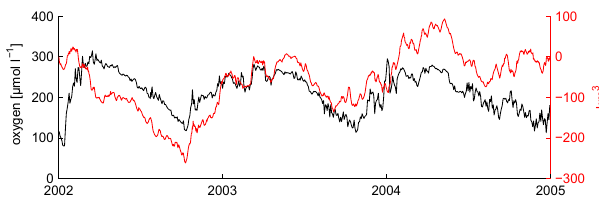
Fig. 8. Simulated DO concentration at station 413 (black line) and the deviations in the accumulated flow from the mean flow through S1 (red line). A negative (positive) gradient of the red line implies a lower (higher) volumetric flow rate then the